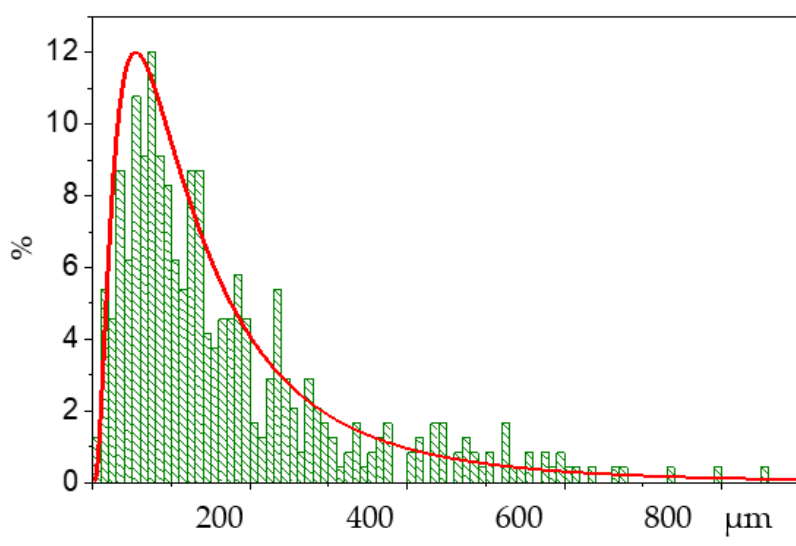
Figure 9. Diagram of grain size distribution in the zone of elastic deformation.